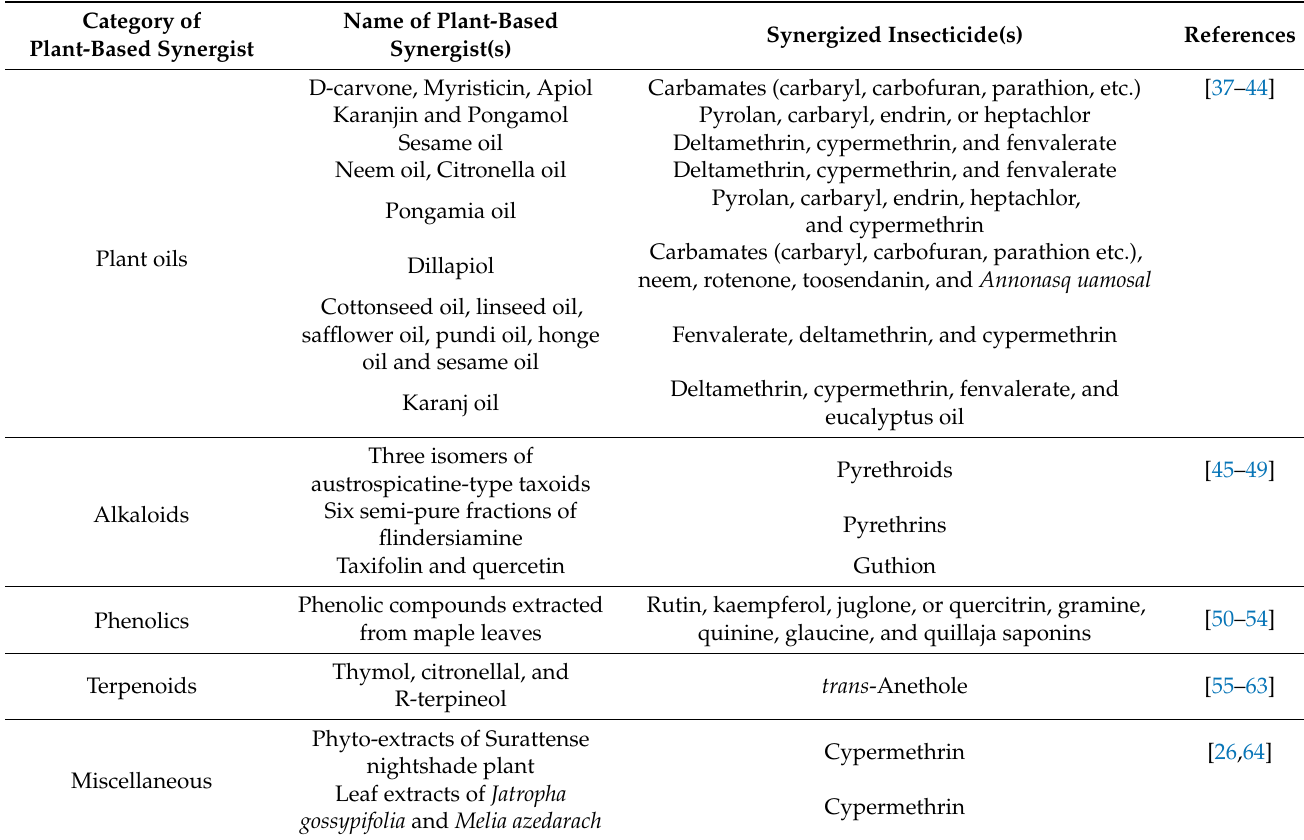
Table 1. Insecticide(s) synergized by addition of different plant-based synergists against different insect